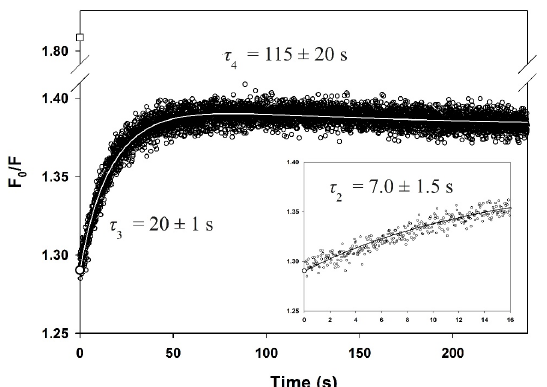
Figure 8. The quenching of intrinsic fluorescence by 81 mM acrylamide during the refolding of PemA. Refolding was carried out in 0.4 M GdmCl and 50 mM sodium phosphate at pH 7 and 25 °C. The data are plotted as the ratio of the intrinsic fluorescence in absence of acrylamide ( F 0 ) to that in the presence of the quencher ( F ). ( □ ) is F 0 /F for the unfolded protein measured as the ratio of the fluorescence intensities of the protein in 4 M GdmCl, with and without acrylamide; ( ○ ) represents the signal of F 0 /F extrapolated to zero time, and the solid line represents the fit of a sum of three exponentials (Equation (2)) to the data. The resulting time constants are indicated, and the inset shows the first 16 s of the reaction.